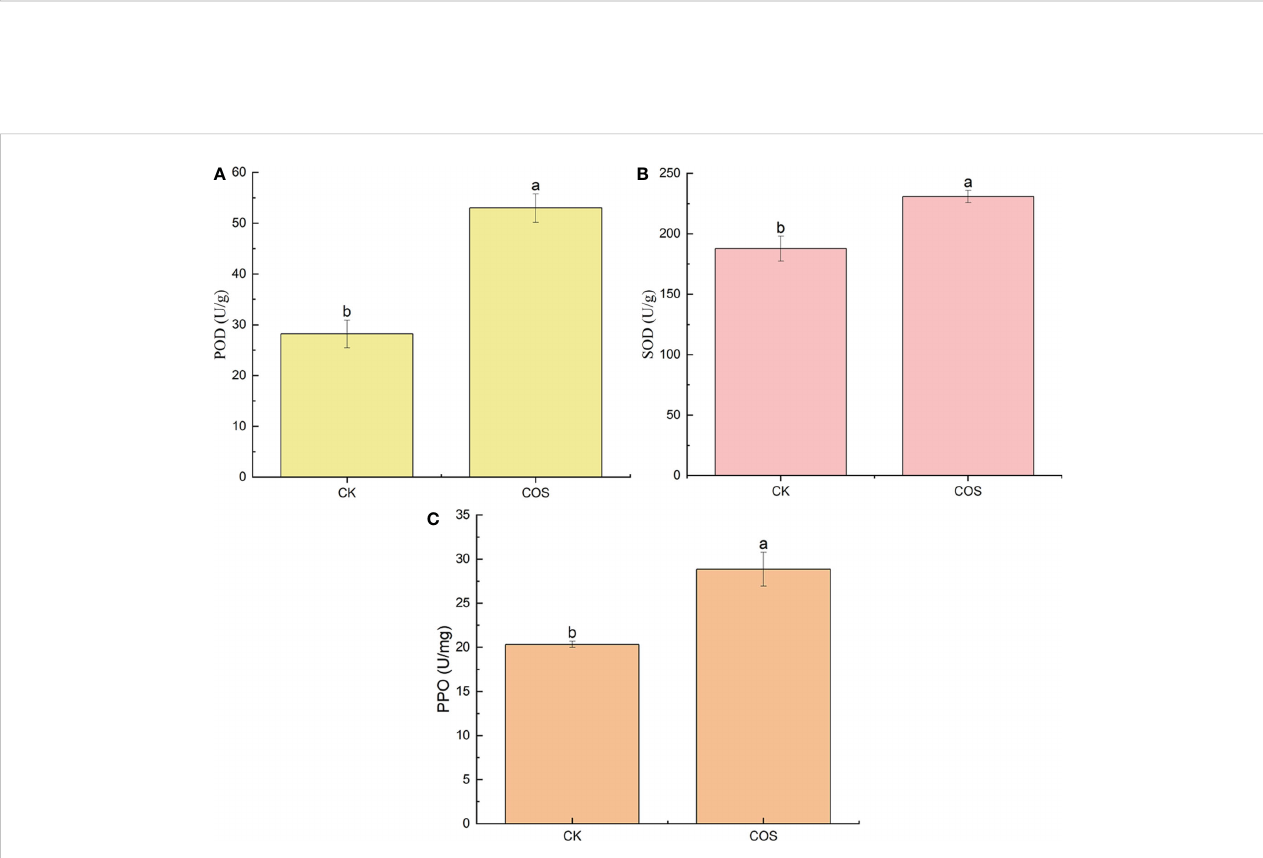
FIGURE 2 Effect of COS on the POD (A) , SOD (B) , and PPO (C) activity in the leaves of Passi fl ora spp. seedlings. Different lowercase letters indicated the effect of COS on the POD, SOD, and PPO activity in the leaves of Passi fl ora spp. seedlings with signi fi cant difference compared with CK group (p <